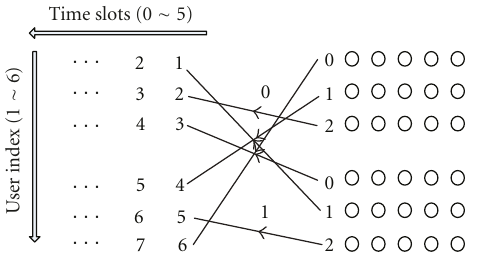
Figure 2: One example of RNS-assisted two-stage hopping